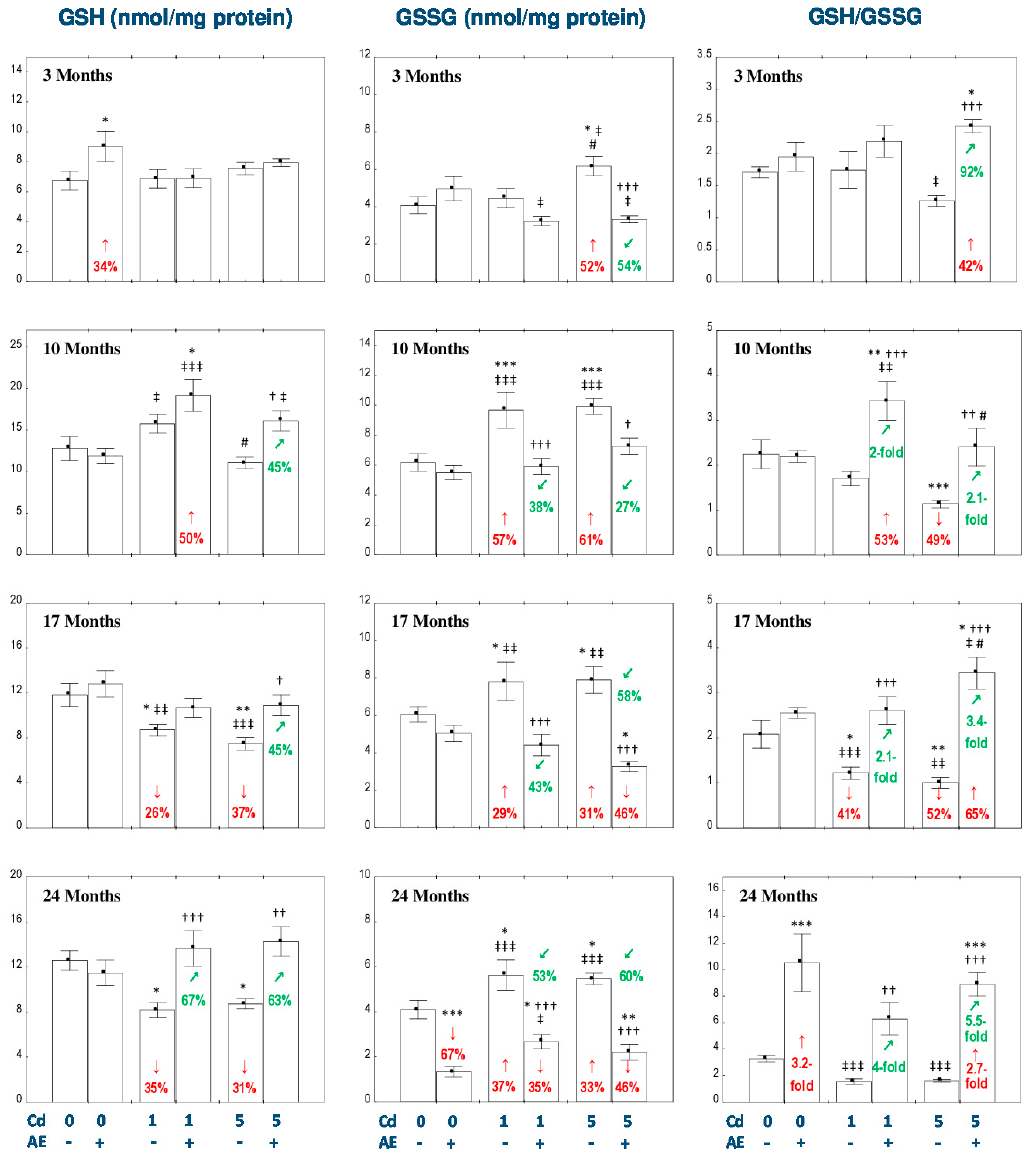
Figure 3. The effect of the extract from the berries of Aronia melanocarpa L. (AE) on the concentrations of reduced glutathione (GSH) and oxidized glutathione (GSSG), and the ratio of GSH/GSSG in the liver of rats exposed to cadmium (Cd). The rats received Cd in the diet at the concentration of 0, 1, and 5 mg Cd/kg and/or 0.1% aqueous AE (+) or not (-). Data are presented as mean ± SE for eight rats, except for seven animals in the AE, Cd 1 , and Cd 5 groups after 24 months. Statistically significant differences (ANOVA, Duncan’s multiple range test): * p < 0.05, ** p < 0.01, *** p < 0.001 vs. control group; † p < 0.05, †† p < 0.01, ††† p < 0.001 vs. respective group intoxicated with Cd alone; ‡ p < 0.05, ‡‡ p < 0.01, ‡‡‡ p < 0.001 vs. group receiving AE alone; # p < 0.05 vs. respective group receiving the 1 mg Cd/kg diet (alone or with AE). Numerical values in bars or above the bars disclose the percentage changes or factors of changes in comparison to the control group ( ↓ , decrease; ↑ , increase) or the respective group receiving Cd alone ( ↙ , decrease; ↗ , increase).